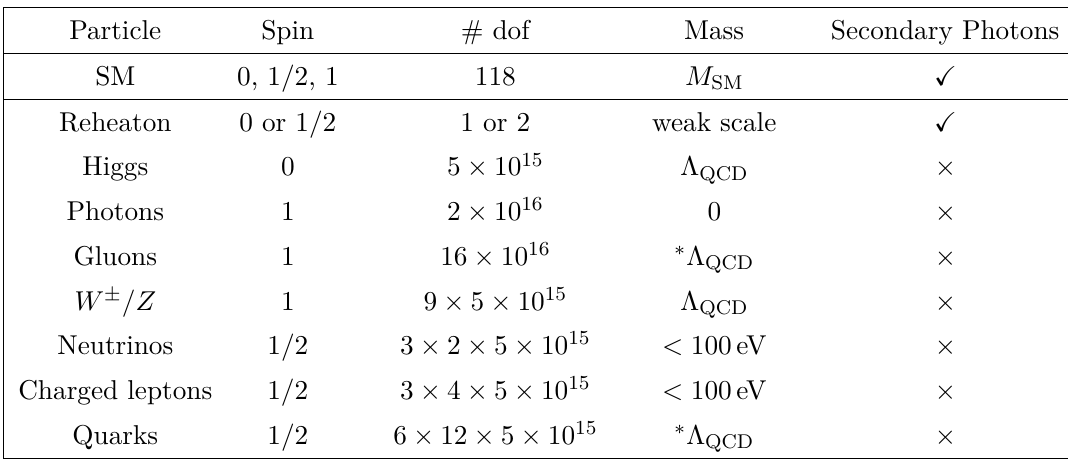
Table 2 . Particle content of the N naturalness benchmark model (with N = 10 16 ) with masses less than the weak scale. We omit SM copies with a vev above the weak scale, see text. ∗ Λ coloured particles with a mass below Λ text in section 3. Assuming N naturalness, black holes evaporating today would have a temperature around 100 eV shortly after the Big Bang, so we treat particles with masses below this scale as